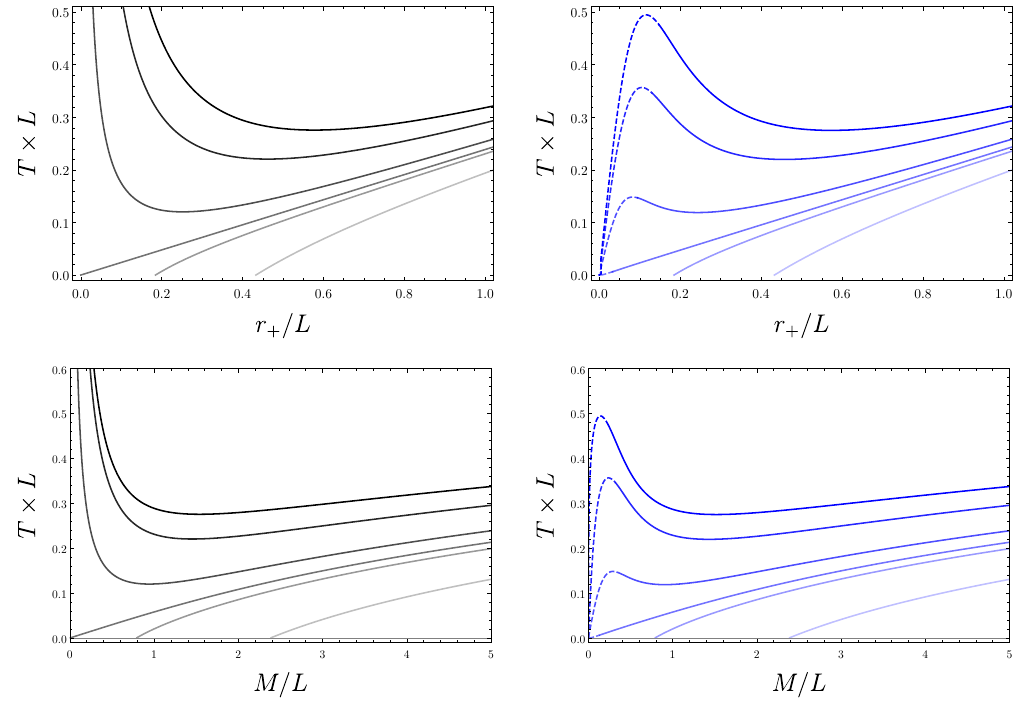
Figure 8 . Four-dimensional black holes in the fixed potential ensemble . Top row : here we display plots of the black hole temperature vs. horizon radius in Einstein gravity (left) and four dimensional generalized quasi-topological gravity (right). The various curves correspond to different values of the potential: Φ = 0 , 1 . 2 , 1 . 8 , 2 , 2 . 1 , 2 . 5 from top to bottom (greatest to least opacity). In the right plot, the dashed portion of the curve indicate negative Wald entropy, and the higher-curvature coupling 3 . Bottom row : here, for exactly the same parameters, we display the has been set to µ/µ = 10 − c temperature plotted against the mass in Einstein gravity (left) and the cubic theory